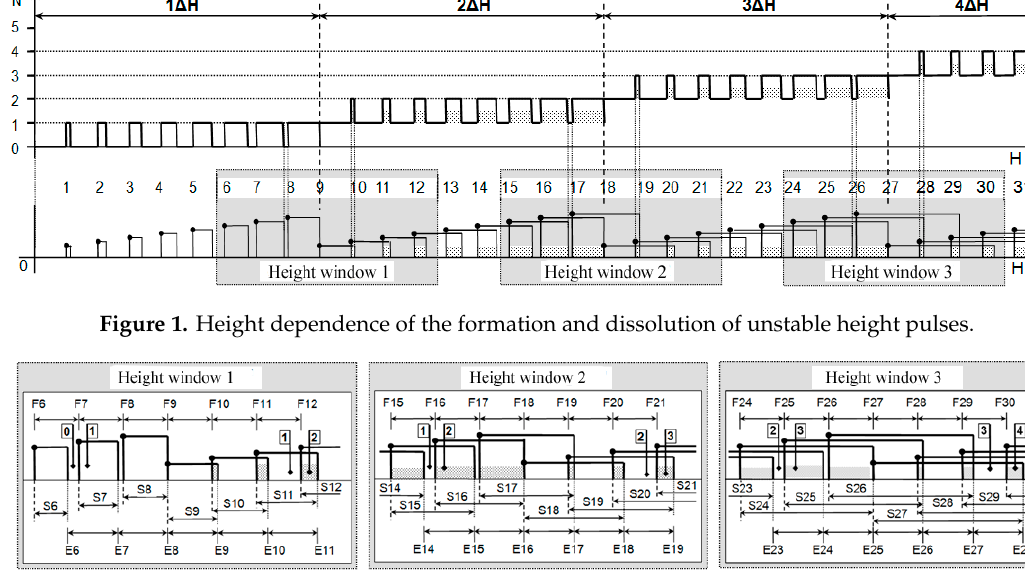
Figure 2. Height ranges and windows in the area of mutual overlapping of unstable height pulses.